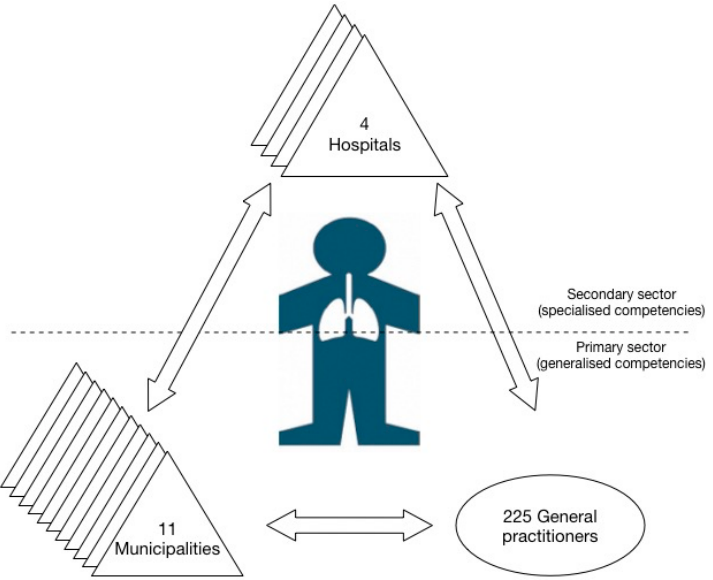
Figure 1. The telemonitoring network.